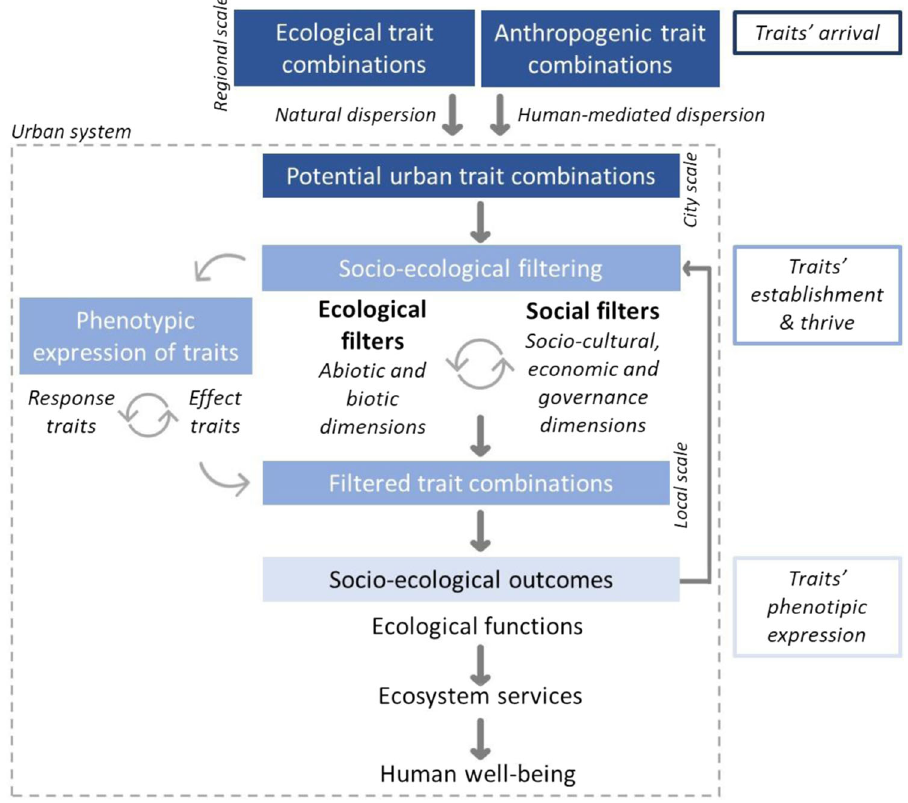
Fig. 1 The Socio-Ecological Traits Framework. The ensemble of ecological (regional scale) and anthropogenic trait combinations disperse to urban systems (natural vs. human-mediated dispersions) making up the potential urban trait combinations (city scale). The potential urban traits are affected by socio-ecological fi lters that often interact. These fi lters comprehend the ecological fi lters of abiotic and biotic dimensions and the social fi lters of socio-cultural, economic, and governance dimensions. The fi ltering processes affect the phenotypic expression of traits (by affecting response traits which feedback to effect traits), resulting in the fi ltered trait combinations at the local scale. The socio-ecological outcomes, which comprise the ecological functions, ecosystem services, and human well-being, are provided by the fi ltered expression of effect traits. These outcomes can then in fl uence the socio-ecological fi